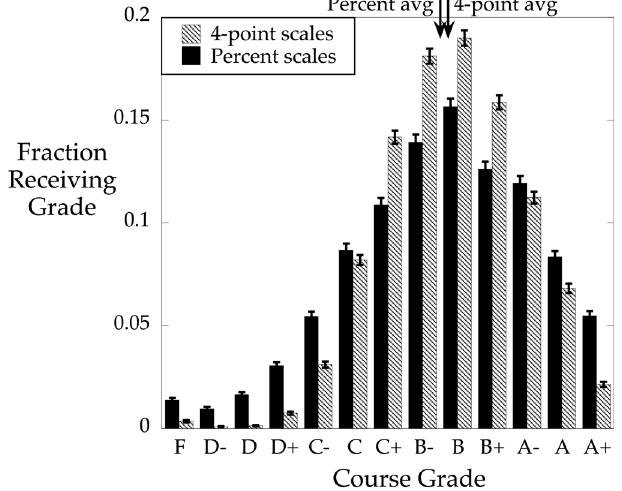
FIG. 3. Fraction of course grades given between 2003 and 2012 for each of the two major grade scales. Error bars are (cid:2) standard error. The average grade is between B- and B for each grade scale but the distribution for the 4-scale classes is notably